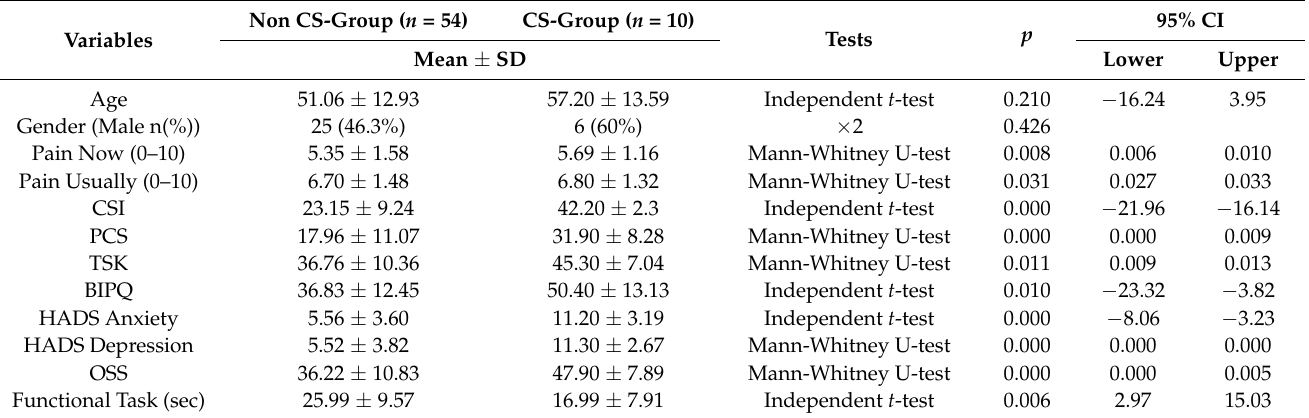
Table 5. Descriptive statistics and statistical analysis of groups with and without central sensitization